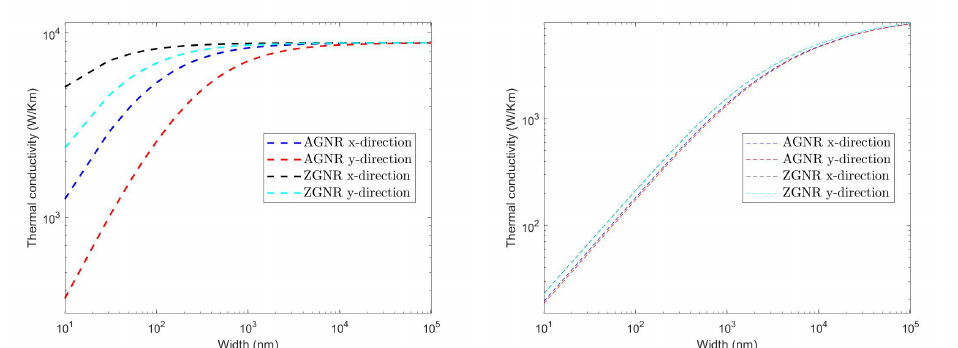
Figure 20. The steady-state thermal conductivity for A and ZGNRs in the x- and y-direction vs the nanoribbon width. ( Left ): with only the es-scattering. ( Right ): with the es– and bs–scatterings. T = 300 K.